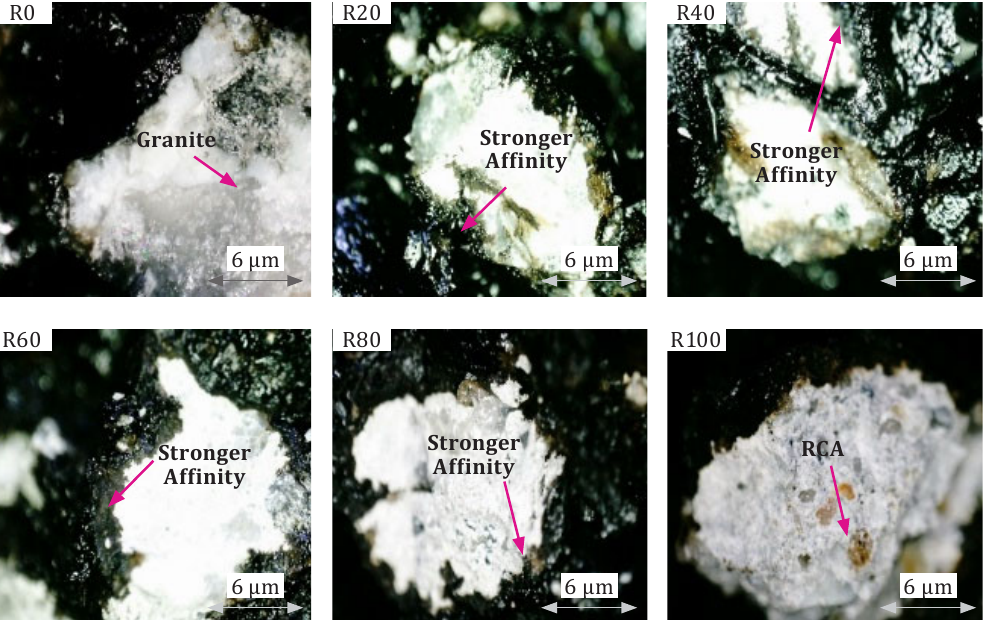
Figure 3 . The bonding of aggregates with bitumen in the porous